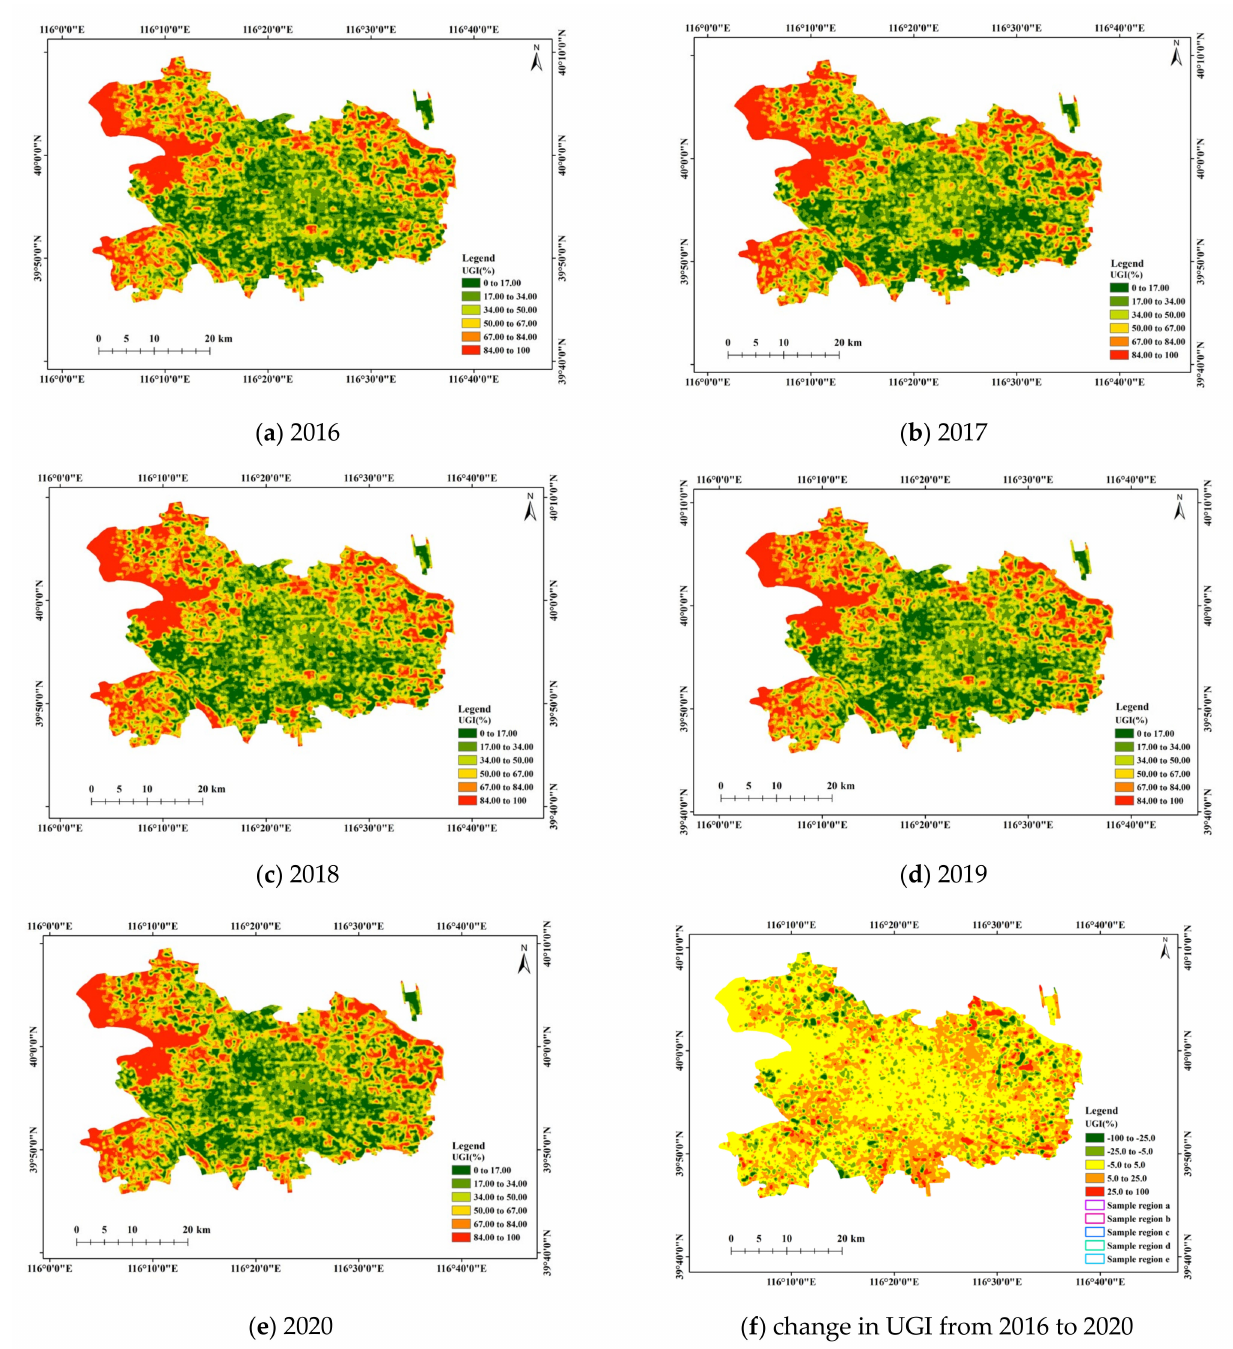
Figure 8. UGI distribution maps of the study area from 2016 to